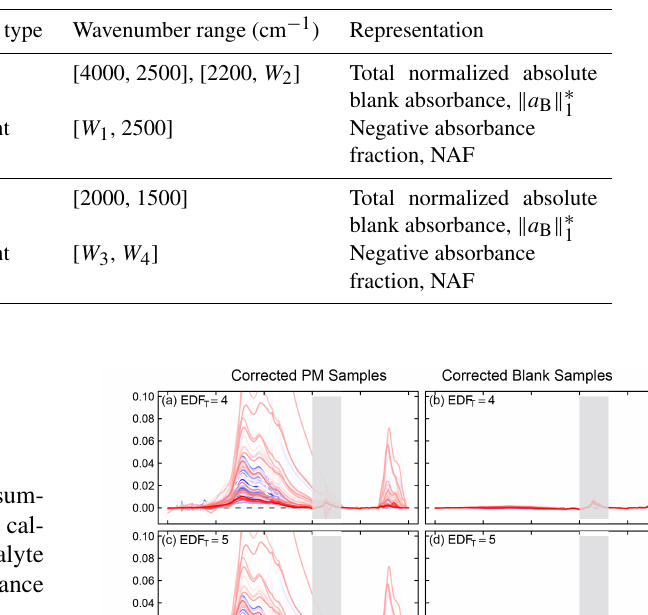
Table 4. Relationship between fitted baseline characteristics as a result of varying EDF and EDF-optimizing metrics to represent these characteristics